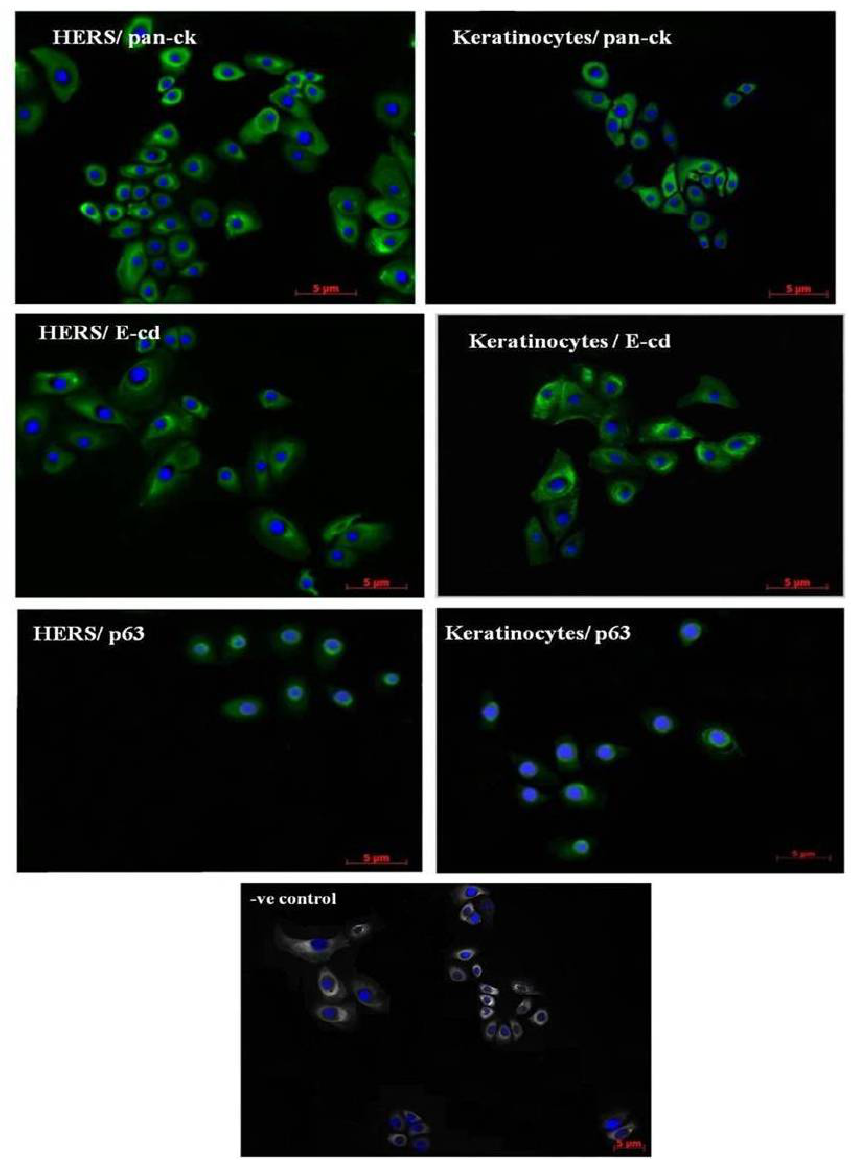
Figure 2. Immunofluorescence staining of HERS cells and keratinocytes for pan-cytokeratin (pan-ck), E-cadherin (E-cd), and p63. The nuclei were counterstained with DAPI. The negative control showed no signal, which supports the validity of our staining. Scale bars = 5 µm, magnification is